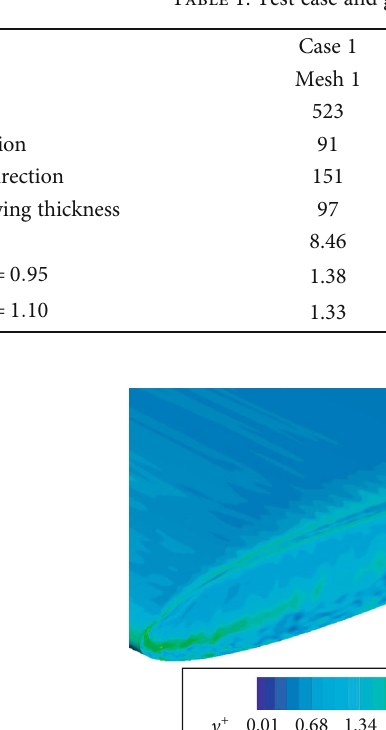
Table 1: Test case and grid information used for veri fi cation.